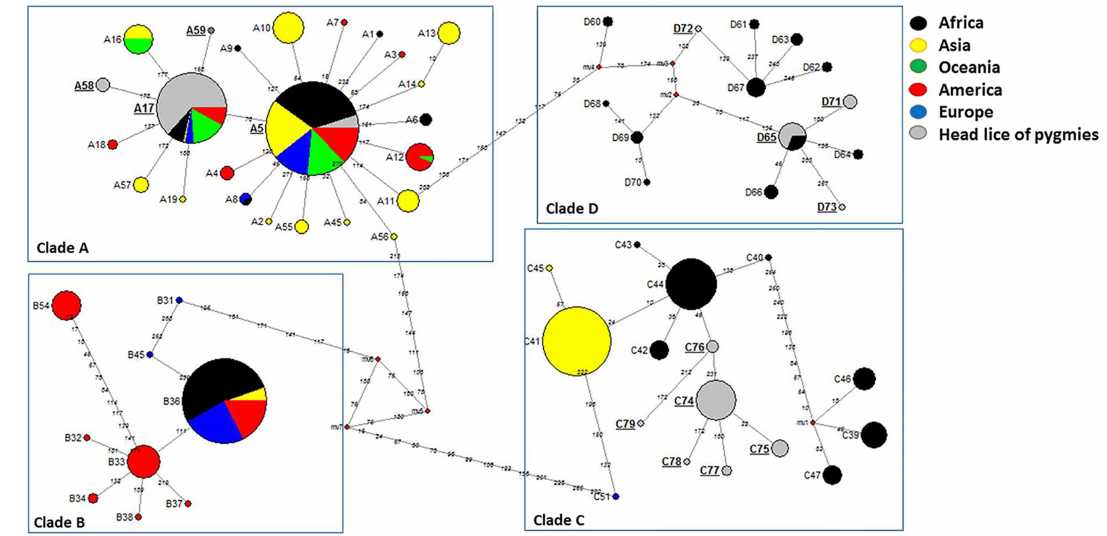
Fig 2. Cytb haplotype networks of human body and head lice. Each circle indicates a unique haplotype and variations in circle size are proportional to haplotype frequencies. Pie colors and sizes in circles represent the continents and the number of their sequence for a haplotype. The length of the links betweennodes is proportional to mutational differences. Haplotypesidentifiedin the present study are in bold.